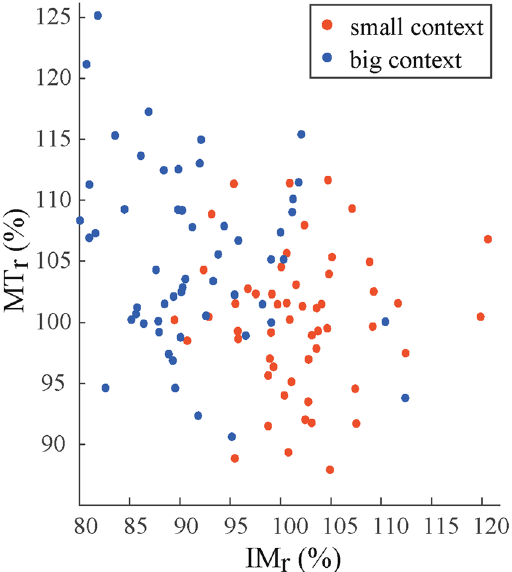
Figure 3. The relative movement time ( MTr ) as a function of relative illusion magnitude ( IMr ; from ref. 27) and context size (for the same participants). Each dot represents a condition for a participant. Red and black dots represent the small and big context condition,